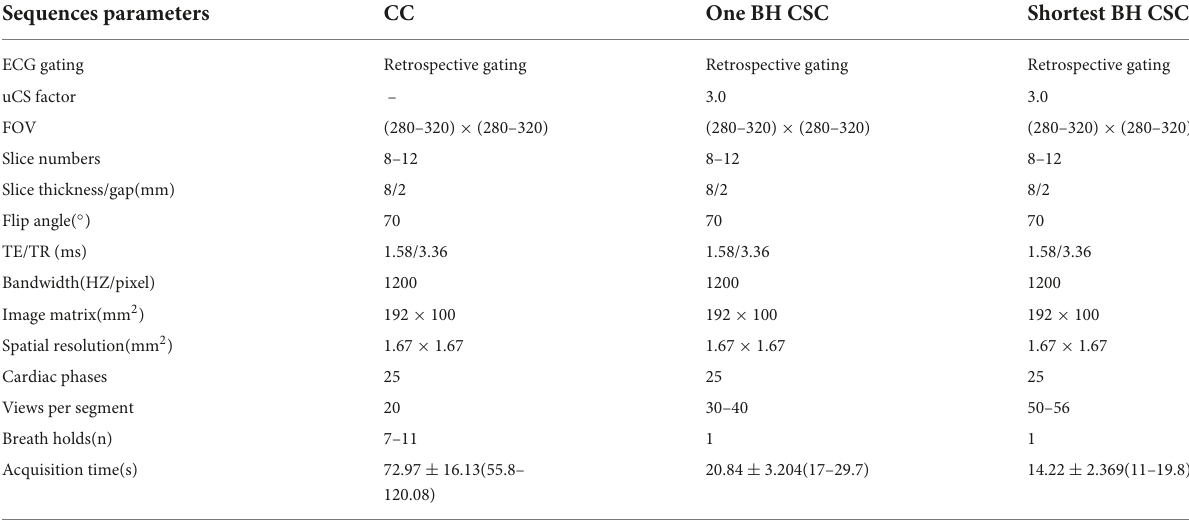
TABLE 1 Typical cardiovascular magnetic resonance (CMR) sequence parameters for conventional and compressed sensing short-axis